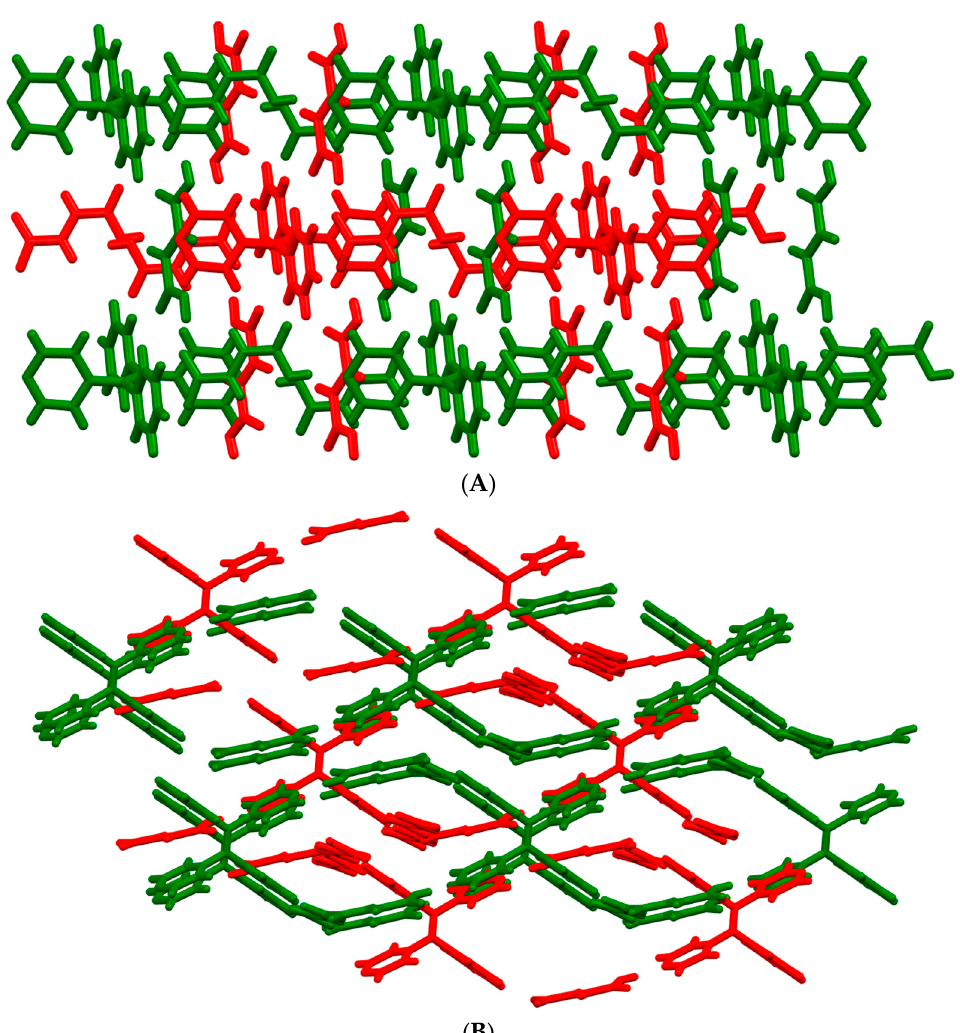
Figure 9. Interpenetration of fumaric acid cross-linked 7 fumarate sheets. Identical independent networks are color coded green and red. ( A ) shows the view down the c axis (parallel to sheet axes); ( B ) shows the view roughly perpendicular to the sheet axes with the ABA stacking motif represented by green–red–green networks.